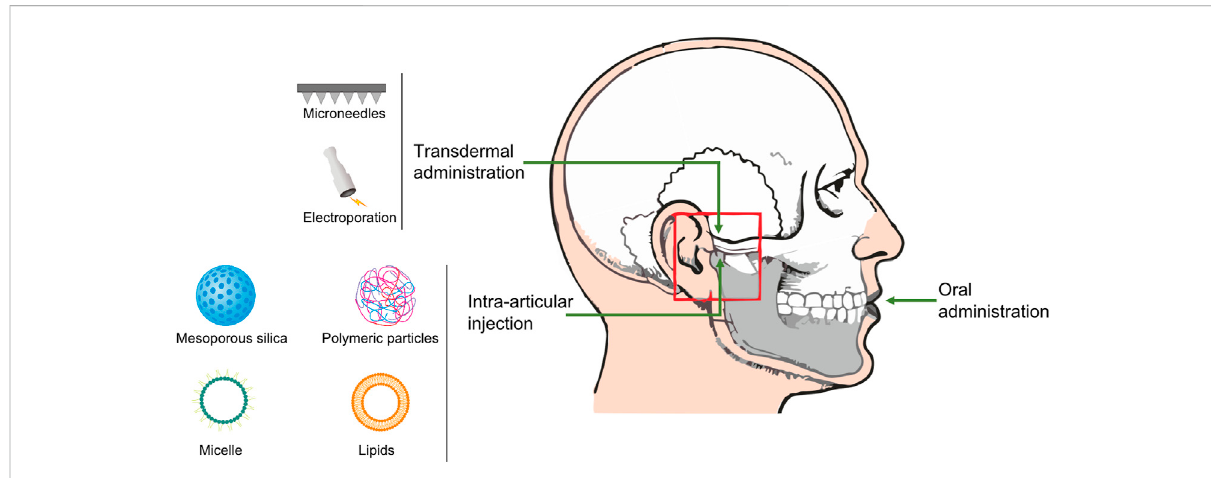
FIGURE 1 Schematic of various nanoparticles and administration routes in the TMJOA